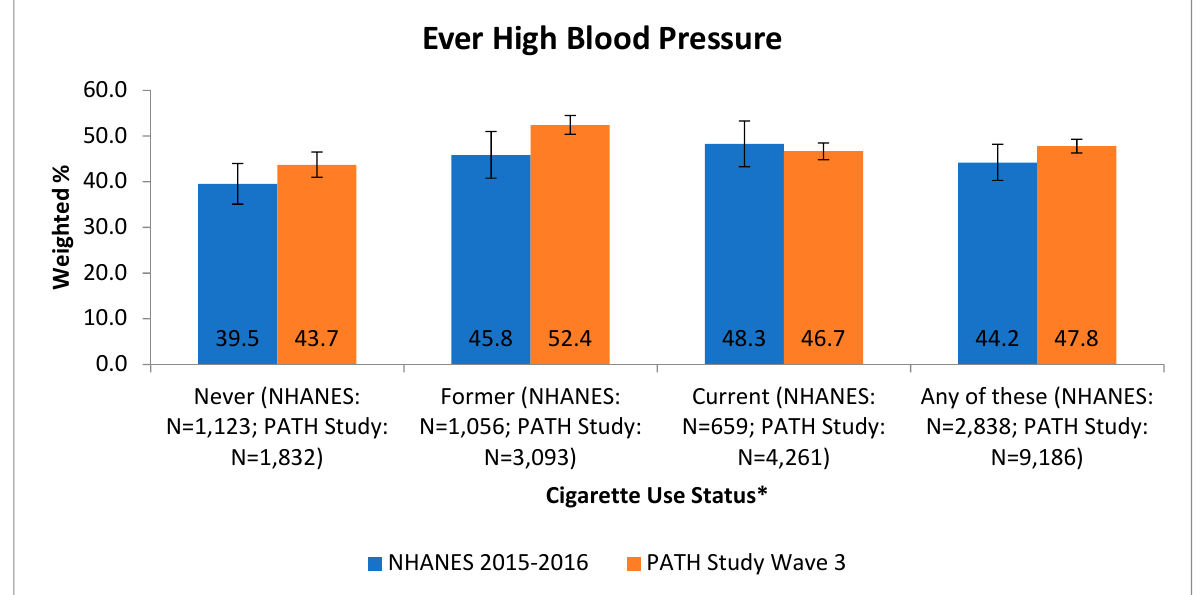
Figure 2. Comparison of PATH Study high blood pressure prevalence with NHANES self-reported prevalence by tobacco user group and overall, age 40+. * NHANES: never: never smoked a cigarette, even one time; former: smoked at